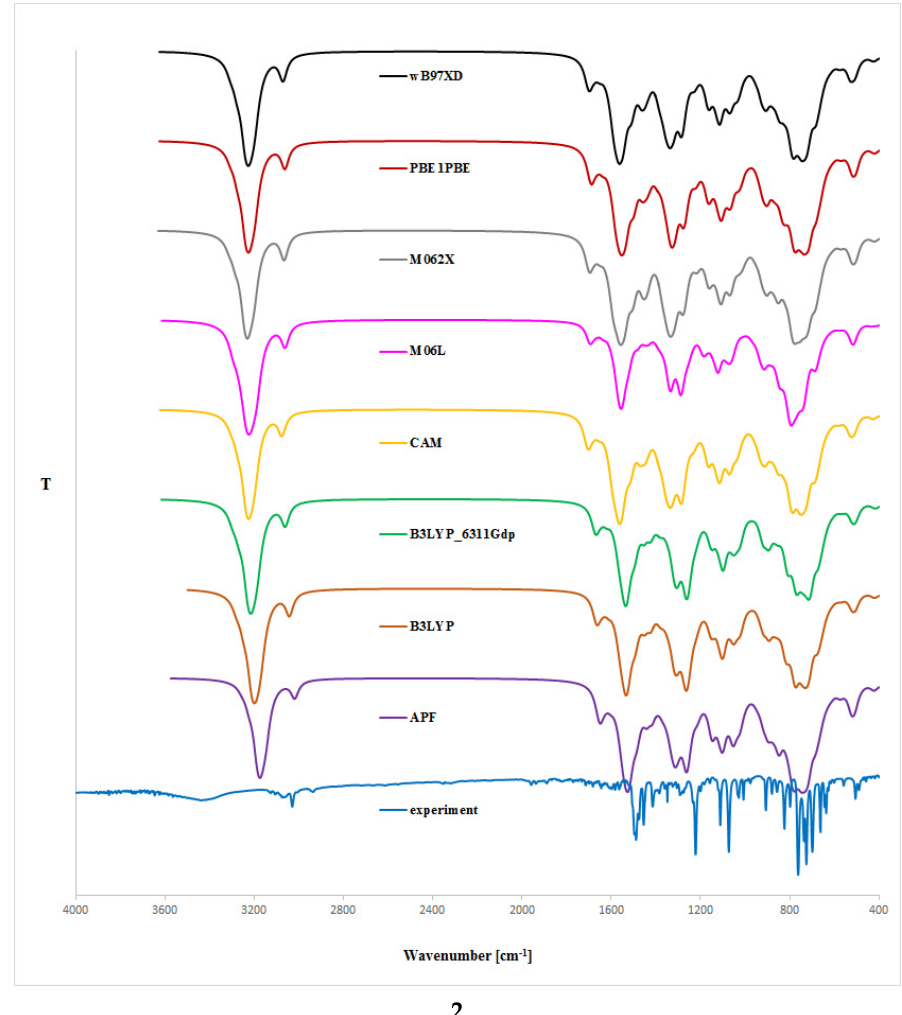
Figure 3. Expended experimental (EXP) and theoretical IR spectra (DFT formalism, gaseous phase) of isoconazole ( 1 ) or bifonazole ( 2 ); B3LYP —B3LYP/6-31G(d,p)//B3LYP/6-31G(d,p) approach, APF -APF/6-31G(d,p)//APF/6-31G(d,p) approach, B3LYP_6311Gdp -B3LYP/6-311++G(d,p)//B3LYP/6-311++G(d,p) approach, CAM -CAM-B3LYP/6-31G(d,p)//CAM-B3LYP/6-31G(d,p) approach, M06L -M06L/6-31G(d,p)//M06L/6-31G(d,p) approach, M062X -M062X/6-31G(d,p)//M062X/6-31G(d,p) approach, PBE1PBE -PBE1PBE/6-31G(d,p)//PBE1PBE/6-31G(d,p) approach, wB97XD -wB97XD/6-31G(d,p)//wB97XD/6-31G(d,p) approach.